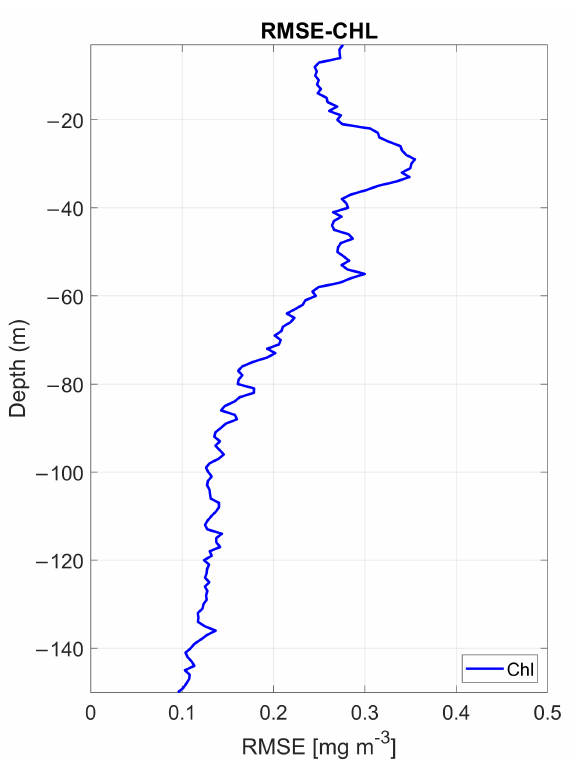
Figure 4. Chlorophyll RMSE profile computed on the test set as a function of depth.